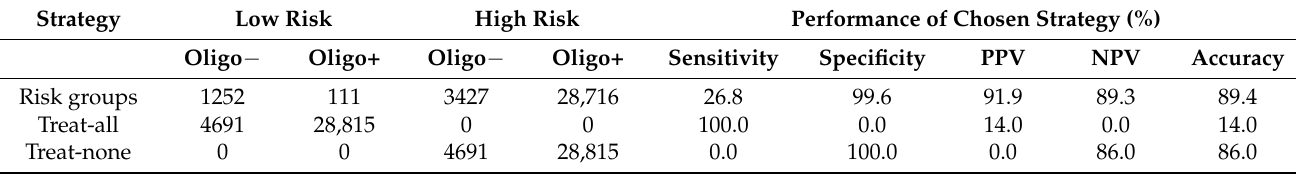
Table 5. Performance of the risk-group-based treatment selection compared to “treat-all” and “treat-none” strategies.